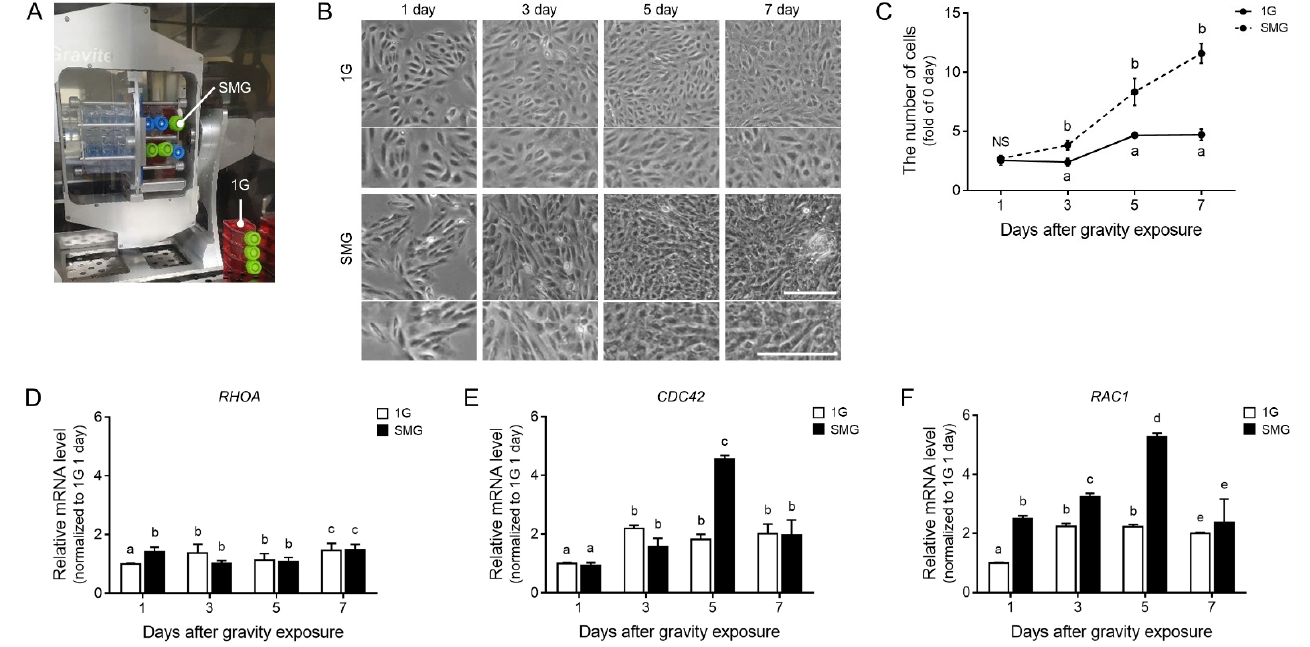
Figure 1. Increased cell proliferation and activated actin cytoskeleton regulator expression in microgravity-stimulated ARPE19 cells. ( A ) ARPE19 cells were grown in 25 cm 2 flasks in the same incubator for 7 days. ( B ) Representative cell images show morphological changes following microgravity stimulation, and the changes can easily be found in enlarged images (bottom row). ( C ) The graph shows the quantified cell number of 1G- (white) or microgravity-stimulated ARPE19 cells (SMG, black). ( D – F ) Relative mRNA levels of ( D ) RHOA , ( E ) CDC42 , and ( F ) RAC1 were confirmed by qRT-PCR. Means denoted by different letters indicate significant differences between groups ( p < 0.05). Scale bar = 200 µ m; CDC42; cell division cycle 42, NS; not significant, RAC1; Rac family small GTPase 1, RHOA; Ras homolog family member A, SMG; simulated